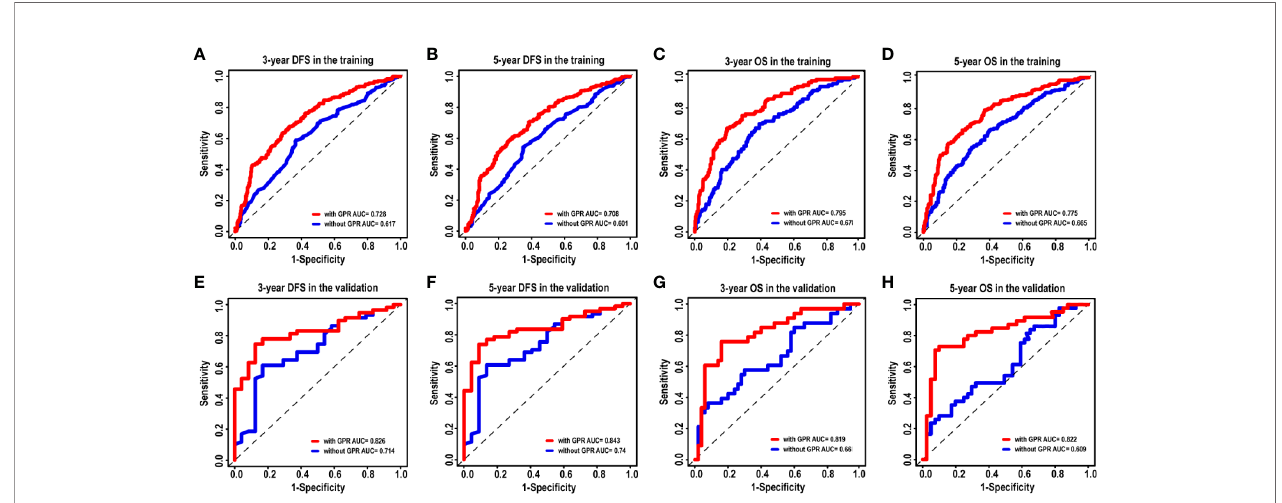
FIGURE 6 | The ROC curves of the nomogram models with and without the GPR for HCC patients. (A – D) ROC curves showing the discriminatory abilities of the nomogram models with and without the GPR for the 3-year DFS (A) and OS (C) rates and 5-year DFS (B) and OS (D) rates in the training cohort. (E – H) ROC curves showing the discriminatory abilities of the nomogram model with and without the GPR for the 3-year DFS (E) and OS (G) rates and 5-year DFS (F) and OS (H) rates in the validation cohort. GPR, gamma ‐ glutamyl transpeptidase ‐ to ‐ platelet ratio; ROC, receiver operating characteristic; HCC, hepatocellular carcinoma; DFS, disease-free survival; OS, overall survival.